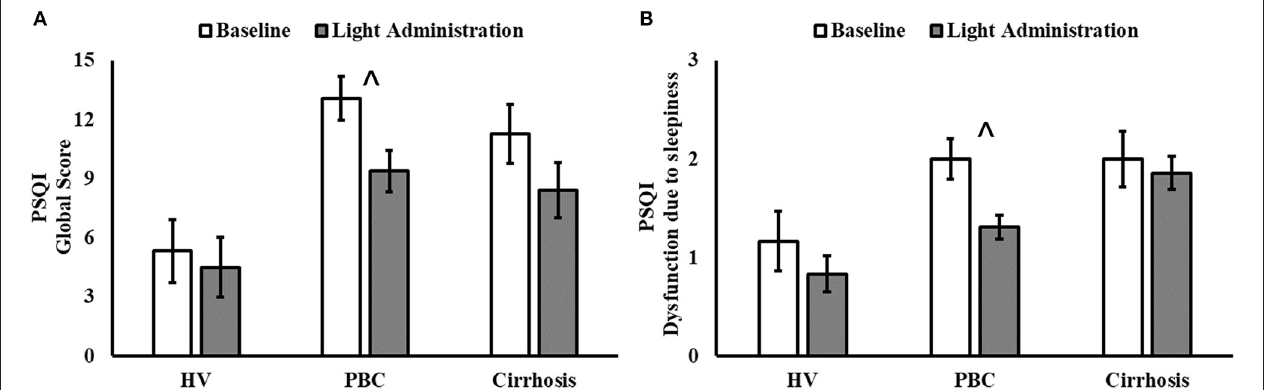
Frontiers in Physiology |